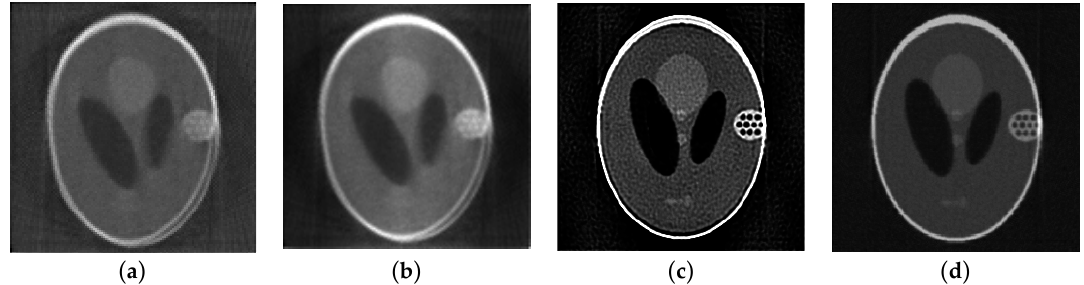
Figure 4. Comparison of the 128th slice of 3D reconstructed images for slight motion: ( a ) Image reconstructed by OSEM; ( b ) Image reconstructed by OSEM reconstruction algorithm with motion correction by BD-iteration (OSEM-BD); ( c ) Image reconstructed by the combination of Richardson–Lucy deconvolution and OSEM reconstruction (RL-OSEM); ( d ) Image reconstructed by the proposed method.